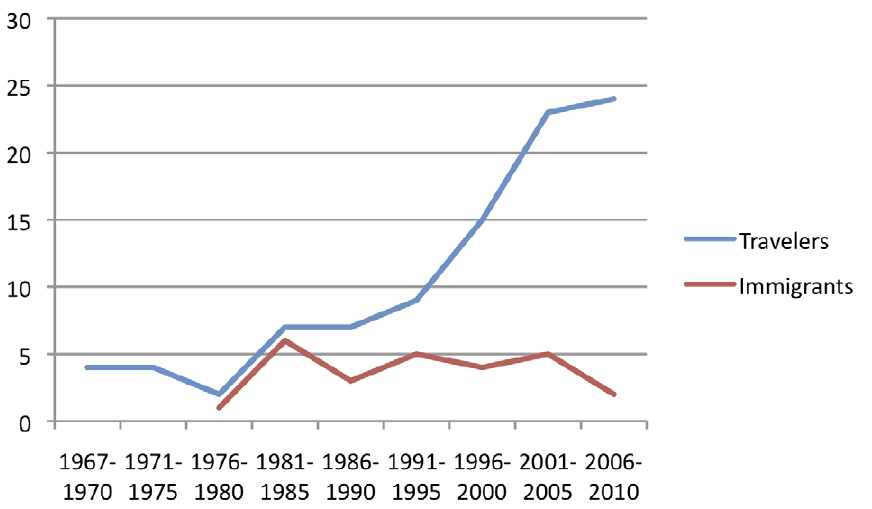
Figure 2. Sleeping sickness reported cases over the years in travelers. Note: The date refers to the date of diagnosis, not to the publication date of the case.